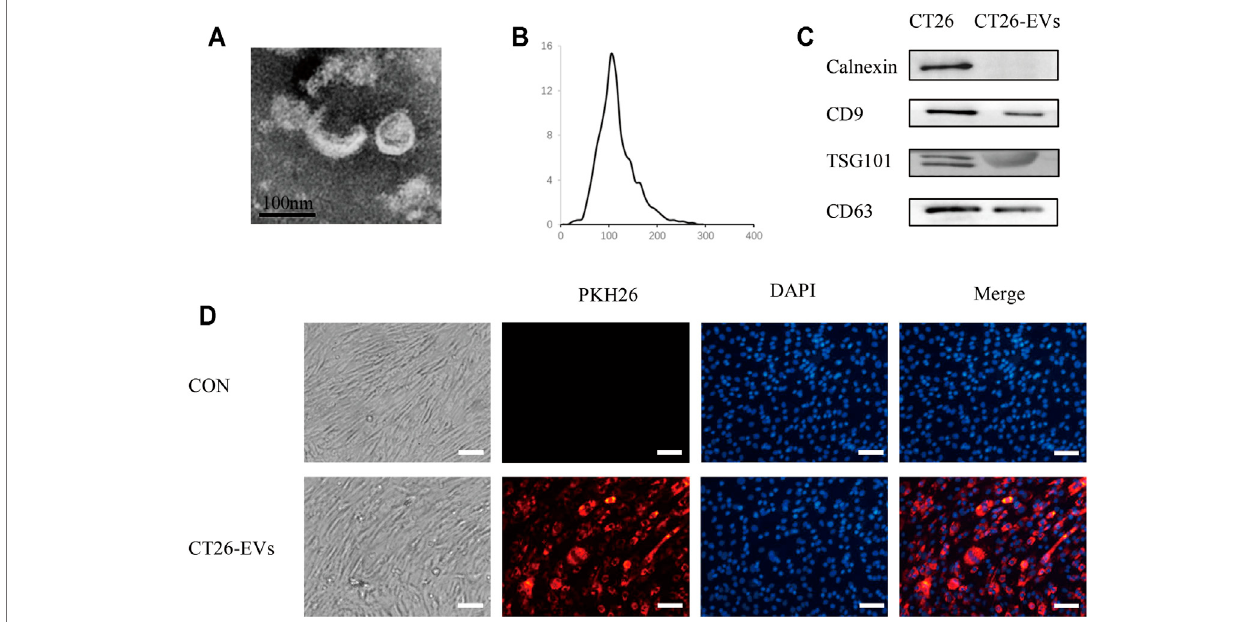
FIGURE1| Isolationandidenti fi cationofCT26-derivedexosomes(CT26-EVs). (A) TransmissionelectronmicroscopyofisolatedexosomesfromCT26cells.Scale bar (cid:2) 100 nm. (B) The concentrationand sizedistribution weredetermined bynanoparticle tracking analysis. (C) Western blotof exosomal marker in exosomes derived from CT26 cells. (D) PKH26 treated exosomes up-taken by C2C12 myotubes. C2C12 myotubes were incubated with PKH26-labelled CT26-EVs (red) . C2C12 myotubes were stained with DAPI (blue) . Scale bar (cid:2) 100 μ m.